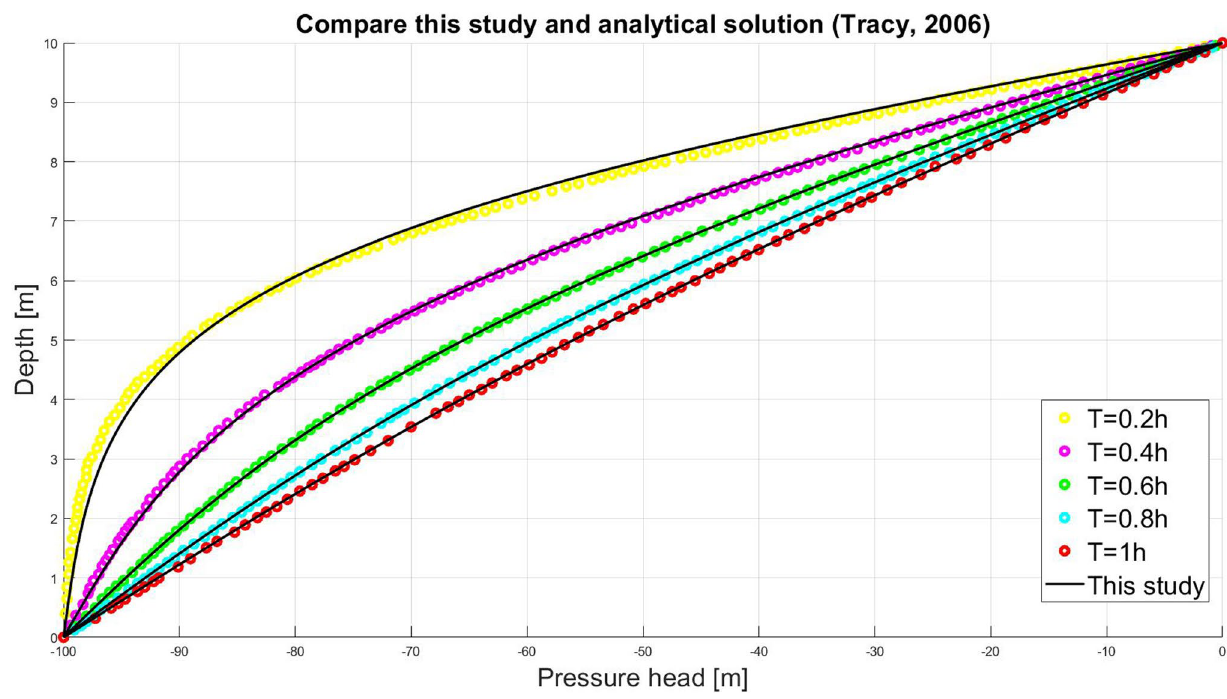
Fig. 2 Comparison of suction profile modeled by meshless Petrov–Galerkin method and analytical solution of Richards